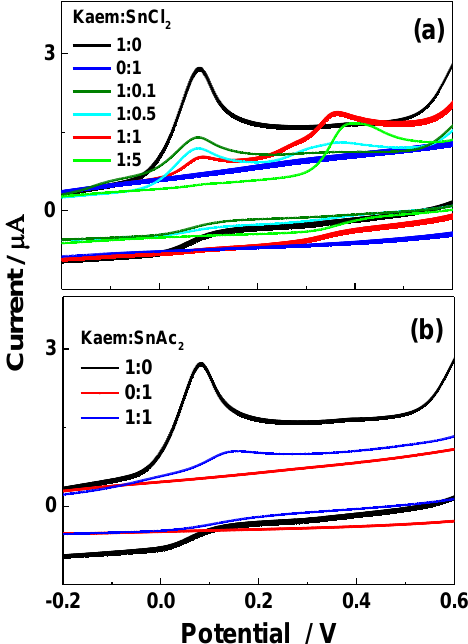
Figure 9. Cyclic voltammograms of 100 µ M HKaem alone and ( a ) 100 µ M SnCl 2 and solutions of 100 µ M HKaem with 10, 50, 100, and 200 µ M SnCl 2 , and ( b ) 100 µ M Sn(OAc) 2 and solutions of 100 µ M HKaem plus 100 µ M Sn(OAc) 2 . All samples were in ethanol relative to 50 µ M ferrocene with 0.1 M sodium perchlorate, NaClO 4 .